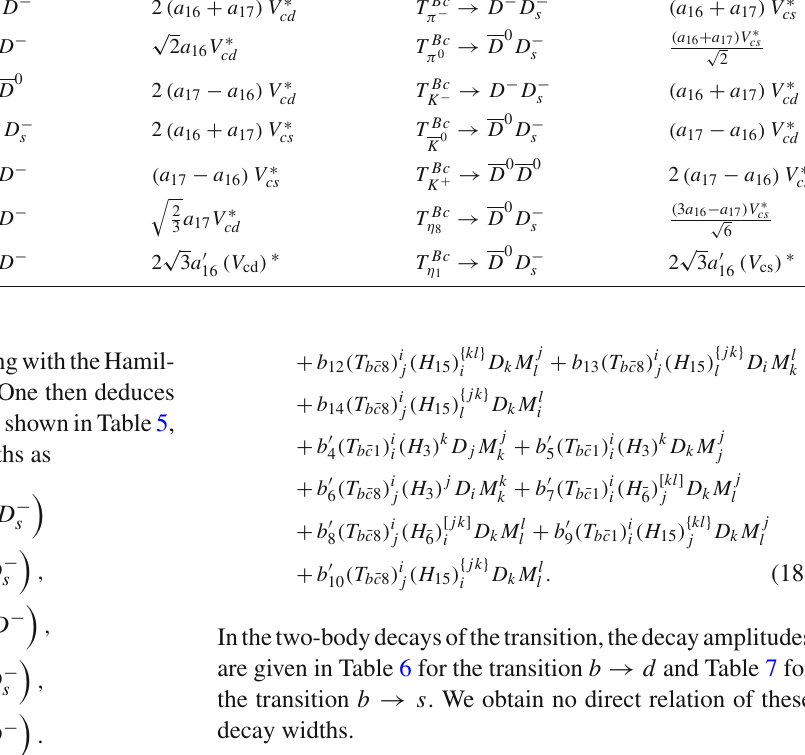
Table 5 Tetraquark T b ¯ c 8 / T b ¯ c 1 Channel Amplitude Channel decays into two anti-charmed mesons